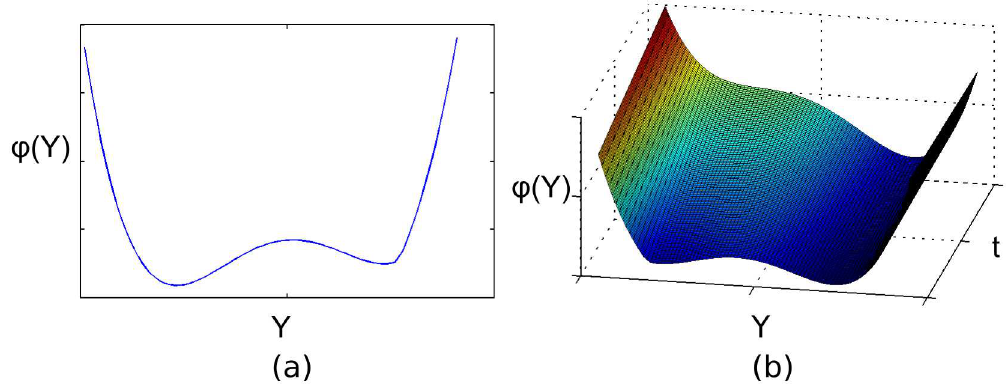
Fig 1. Hypothetical potential landscape ϕ ( Y ) as function of a state variable Y . (a): The landscapeis static in time. The black ball represents the current system state. The two valleys correspond to two separate stability domains.(b): The landscapechangesover time. At t = 0 the landscapeis identicalto (a). Over time, the leftmost stability domain becomes less resilient and eventually